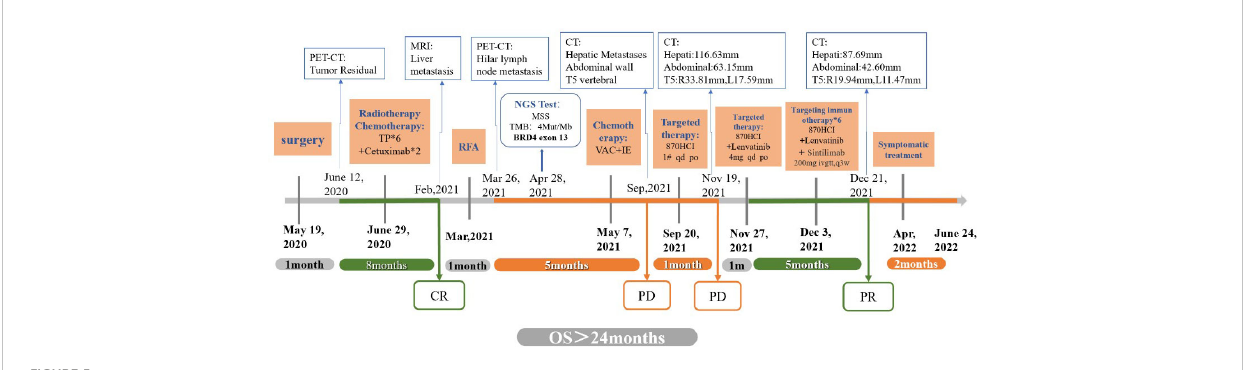
FIGURE 5 Timeline. The bold black text above the time axis indicates the time point of each examination; the bold blue text below the time axis indicates the time point of each